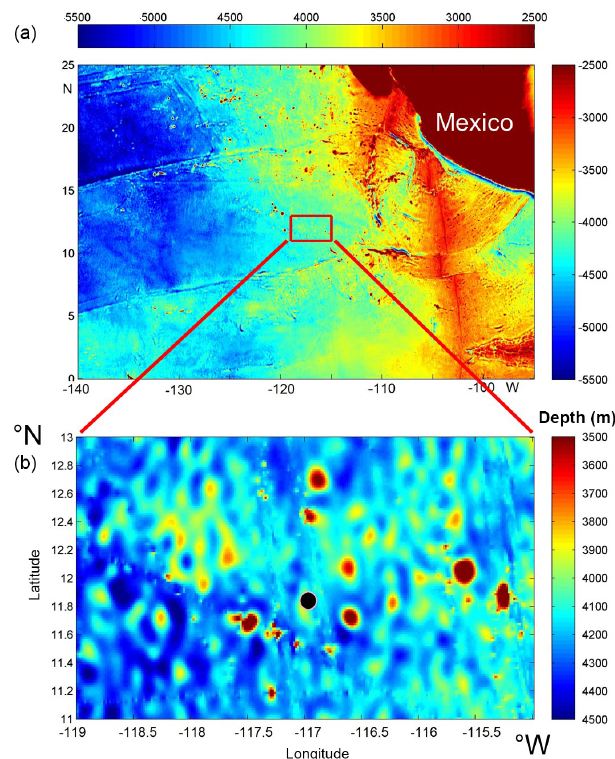
Figure 1. Bathymetry map of the tropical north-east Pacific based on the Topo_9.1b 1 (cid:48) version of satellite altimetry-derived data by Smith and Sandwell (1997). The black dot in panel (b) indicates mooring and CTD positions. Note the different colour ranges be- tween the